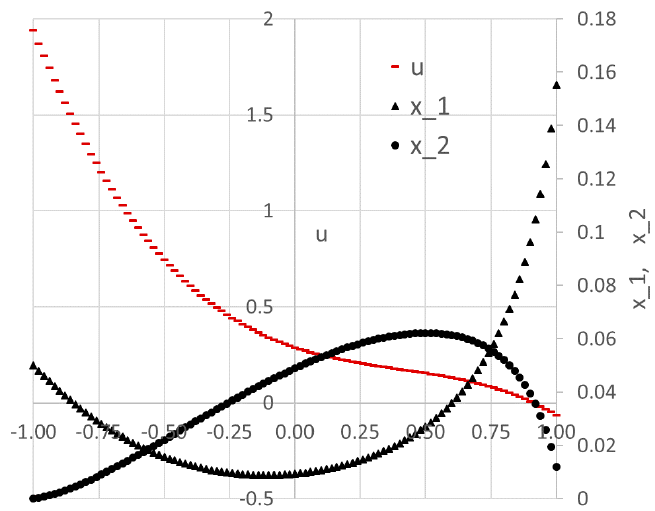
Figure 13. Optimal trajectories for optimal control problem (12)–(15) found by Excel’s Solver starting from a different initial guess, leading to a lower objective value.